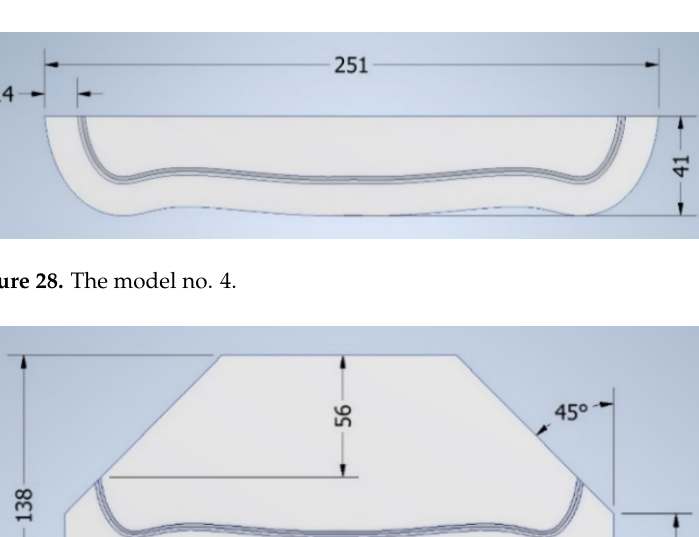
Figure 27. The model no. 3.